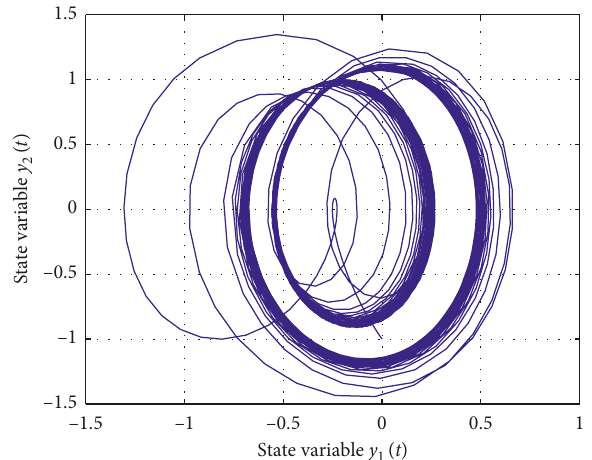
Figure 2: The simulation result for the master system.